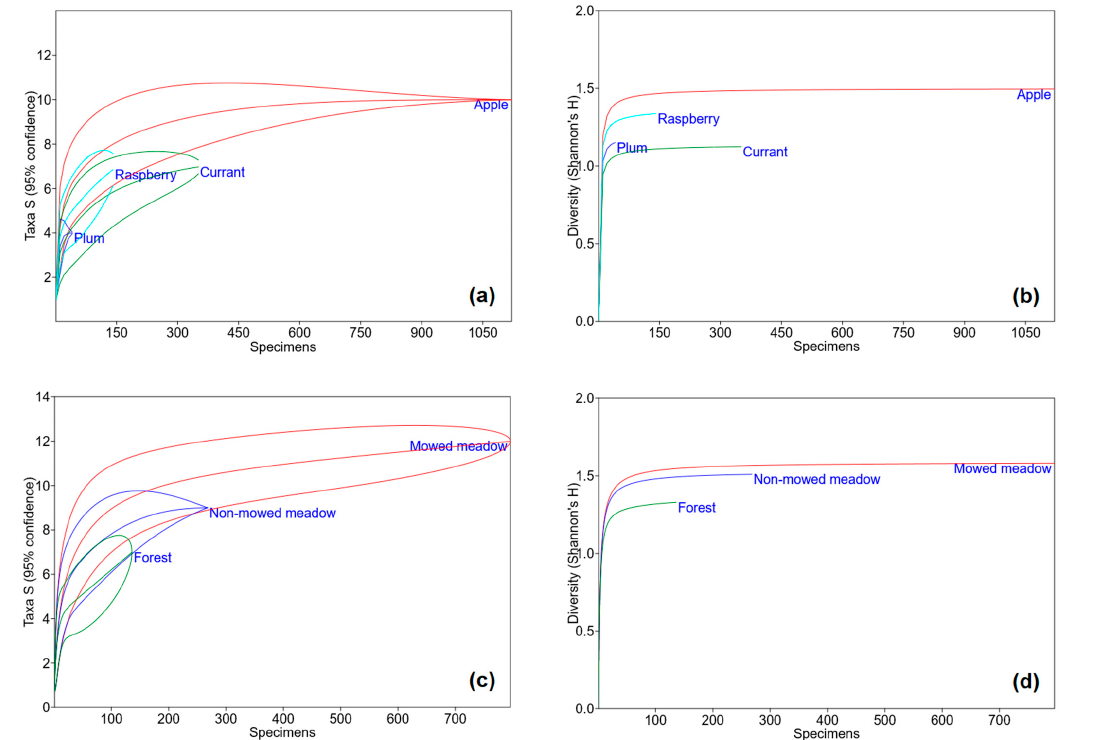
Figure A1. Small mammal species accumulation curves and diversity in relation to trapping effort: ( a )—diversity in orchards, ( b )—number of species in orchards, ( c )—diversity in control habitats, ( d )—number of species in control habitats [96]. Calculated in PAST version 4.01 (Paleontological Museum, University of Oslo, Oslo, Norway) [97].